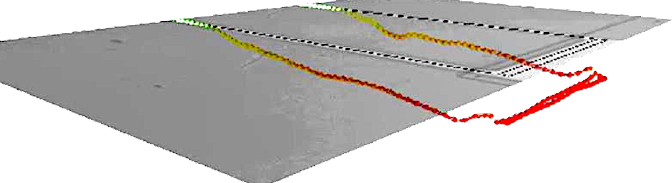
Figure 3. Experimentally obtained first out-of-plane bending mode shape of the sensor.